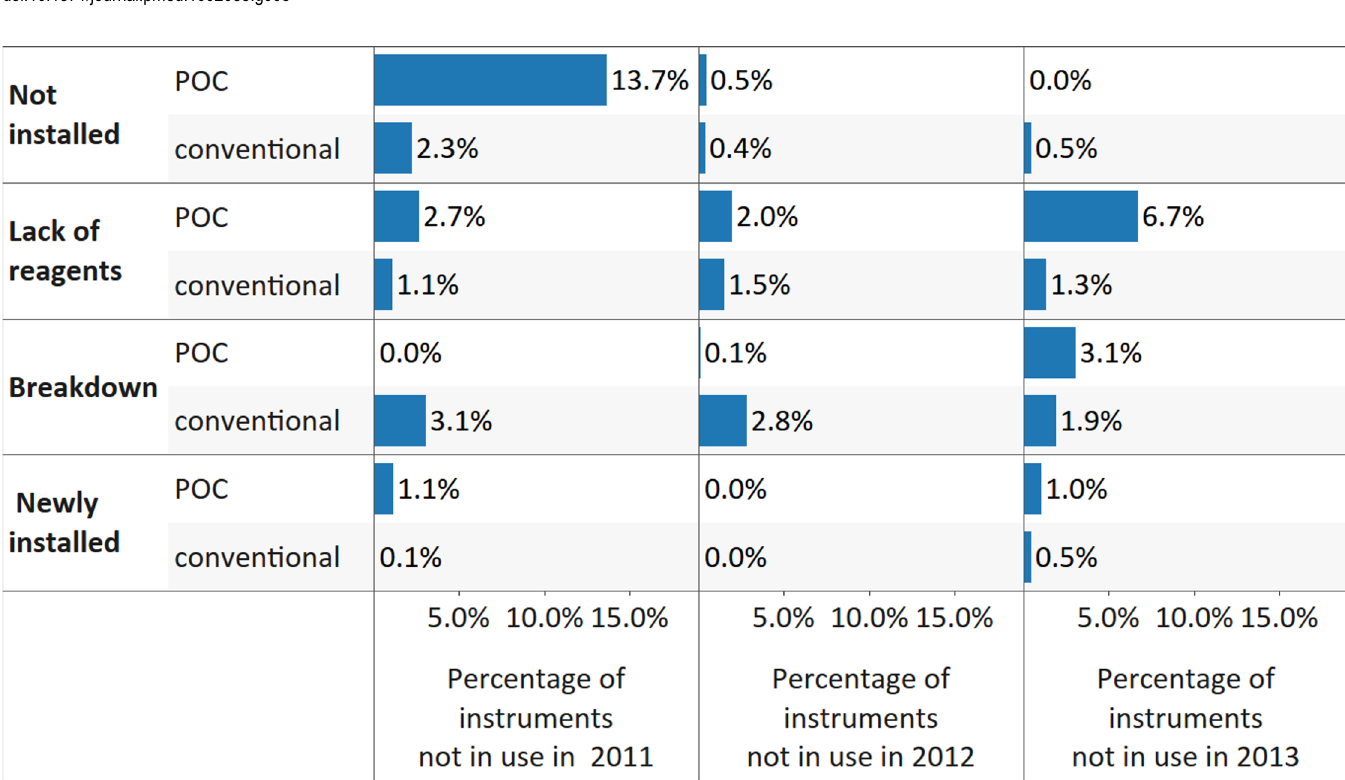
Fig 5. Nonutilization of CD4 instrumentation in reporting countries by survey year and CD4 platform (conventional CD4 versus point of care (POC) CD4). Data labels indicate percentage from the number of all reported CD4 instruments, from CD4 POC, or from CD4 conventional instruments in a particular year.